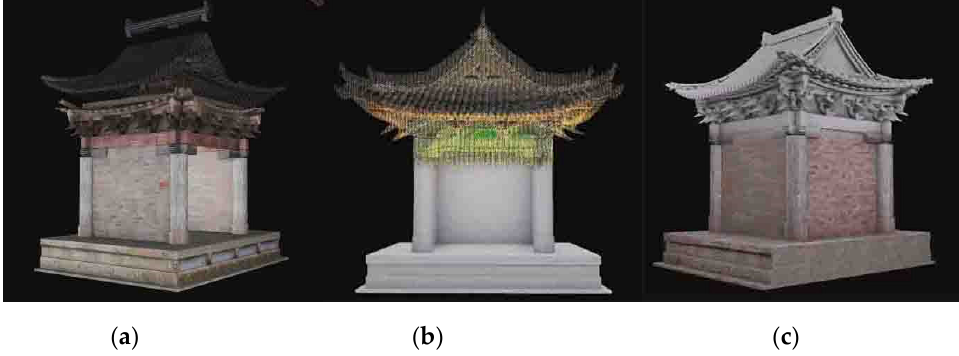
Figure 9. Three-dimensional growth animation of Erlang Temple Stage. ( a ) Architectural growth. ( b ) Growth from point cloud to prime mode. ( c ) Growth from prime model to texture model.